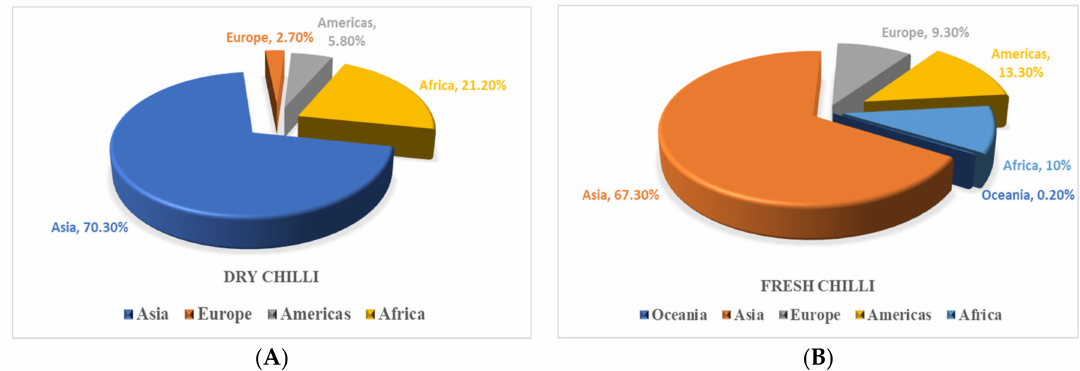
Agronomy 2021 , 11 , x FOR PEER REVIEW Figure 2. Dry ( A ) and fresh ( B ) pepper production by area (www.faostat.fao.org, accessed on 6 January 2019).